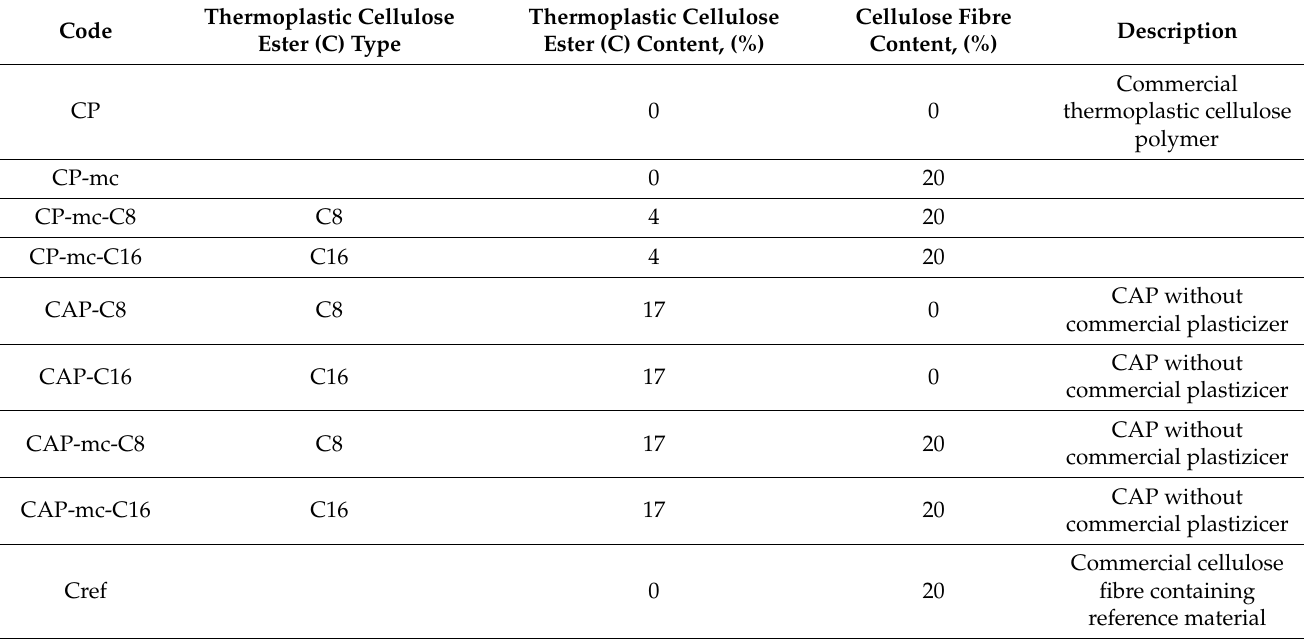
Table 1. Test series of